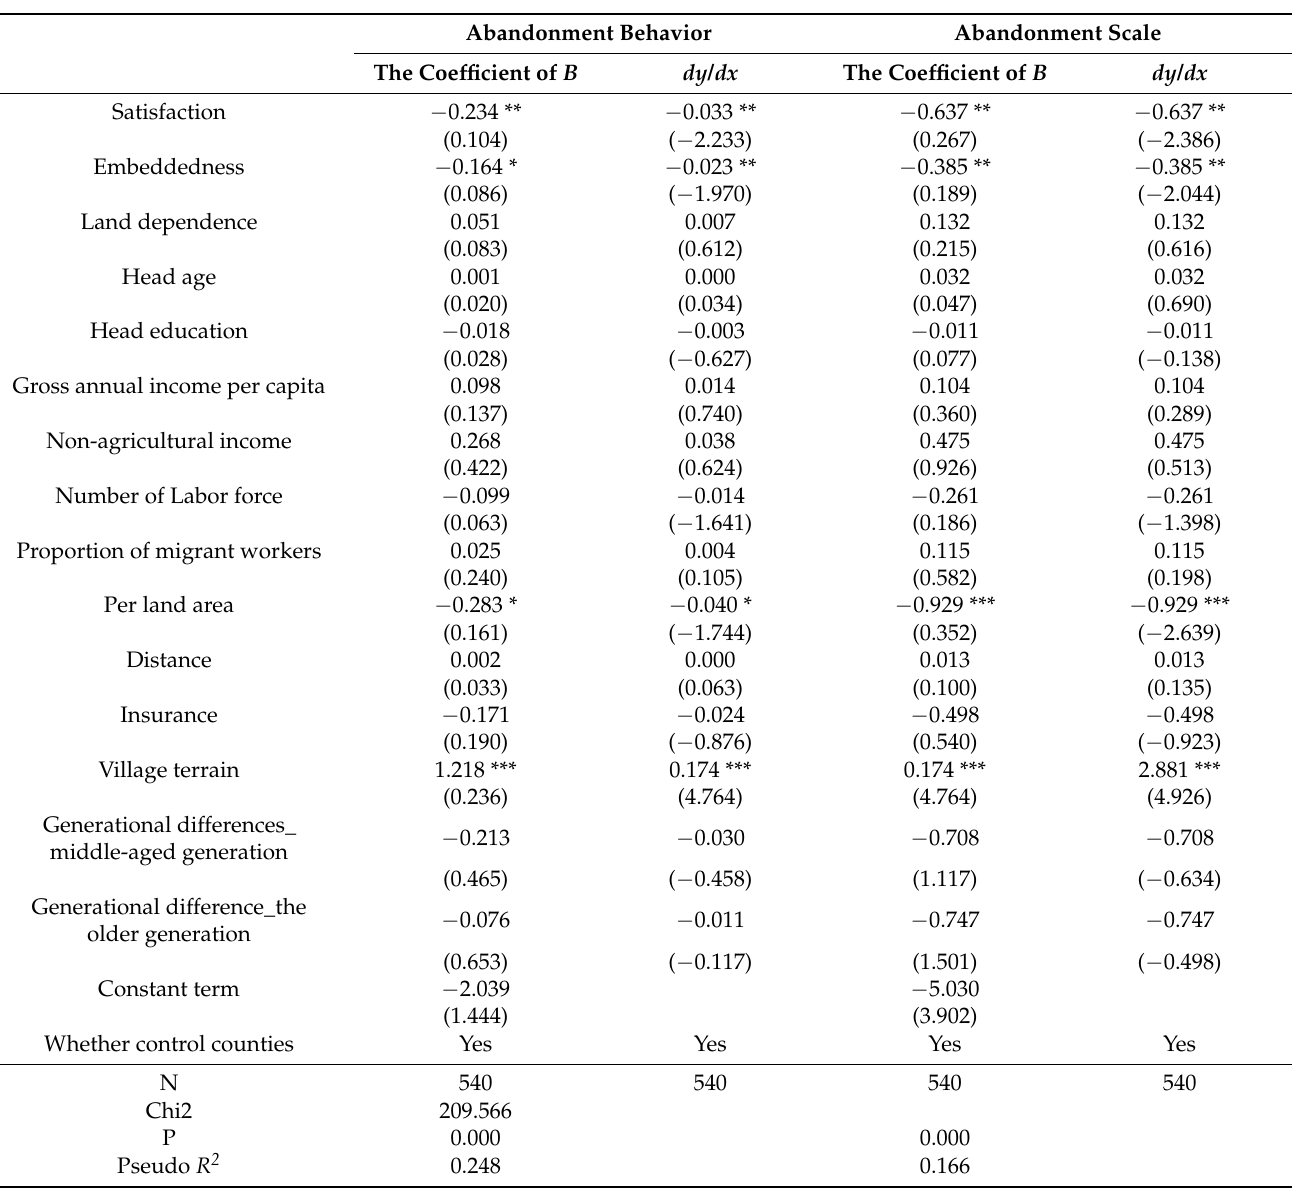
Table 2. Baseline regression of the influence of land attachment on land